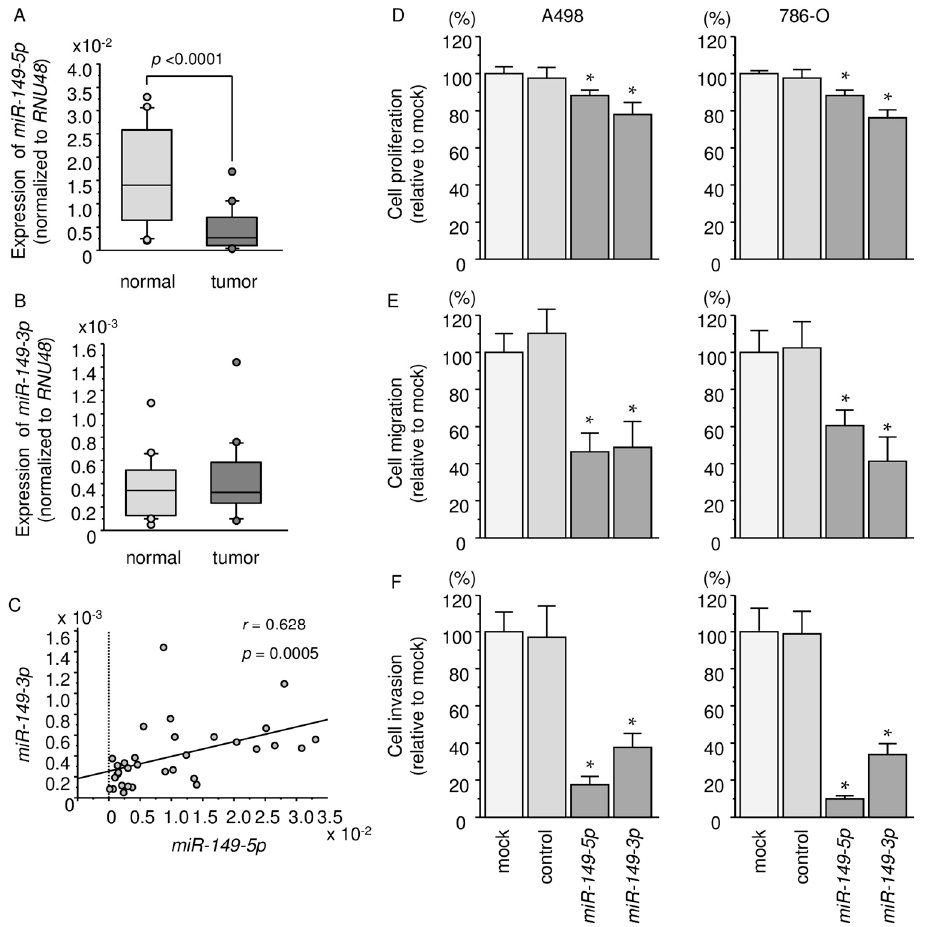
Figure 1. Analysis of miR-149-5p and miR-149-3p expression in clinical specimens and functional assays in renal cell carcinoma (RCC) cell lines (A498 and 786-O cells) following miR-149-5p and miR-149-3p transfection. ( A , B ) Expression levels of miR-149-5p and miR-149-3p in RCC clinical specimens were determined by qRT-PCR. Data were normalized to RNU48 expression; ( C ) Correlation between the relative expression levels of miR-149-5p and miR-149-3p ; ( D ) Cell proliferation was determined by XTT assays. * p < 0.0001; ( E ) Cell migration activity was determined by wound-healing assays. * p < 0.0001; ( F ) Cell invasion activity was determined using Matrigel invasion assays. * p < 0.0001.